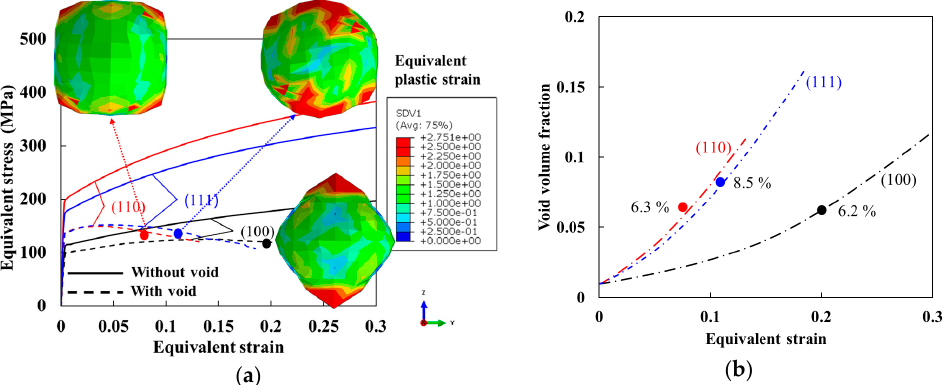
Figure 5. ( a ) stress–strain curves of RVEs with a void in a single crystal with different crystal orientations. The figure indicates the deformed void in which the color code represents the equivalent plastic strain at one-layer elements surrounding void under a constant stress triaxiality of 3; ( b ) evolution of void volume fraction (or void growth rate) as a function of macroscopic RVE equivalent strain with different crystal orientations under a constant stress triaxiality of 1.